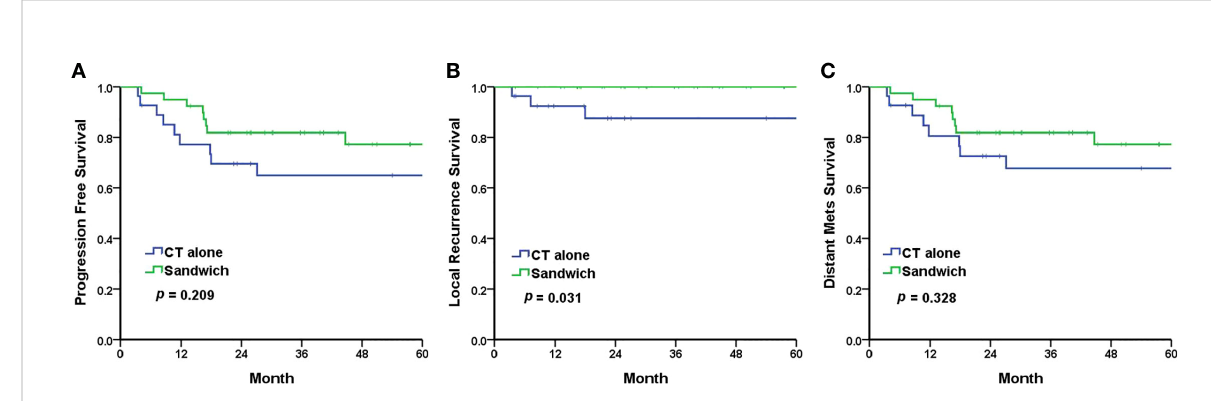
FIGURE 1 The Kaplan – Meier survival curves for 5-year progression-free survival (A) , local recurrence (B) , and distant metastasis (C) . CT, chemotherapy; mets,